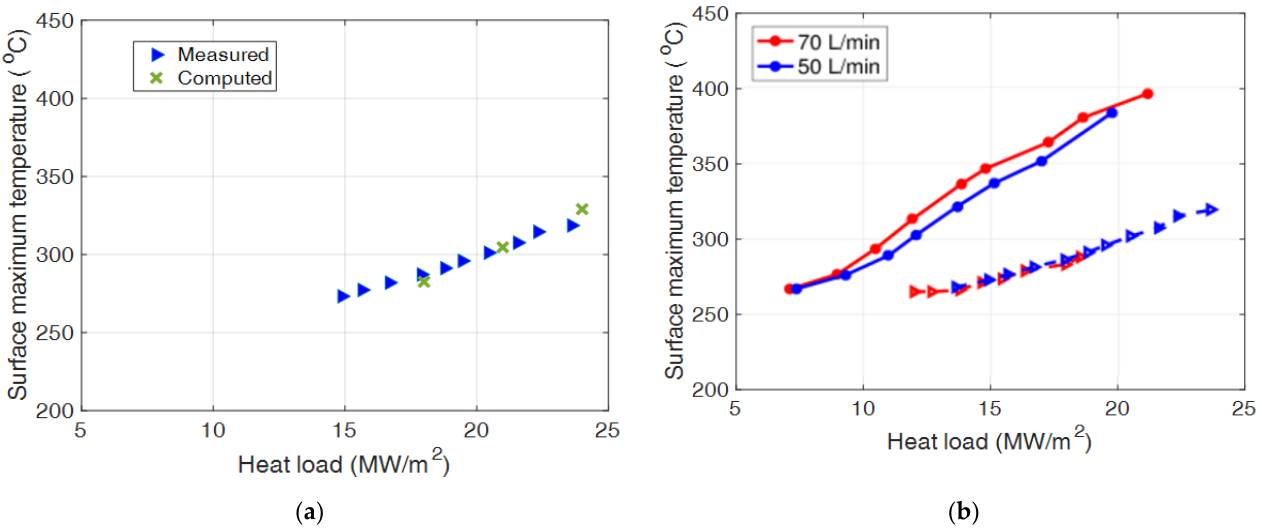
Figure 5. Cavity planar mock-ups equipped with RR: surface temperature measured as a function of the heating power. ( a ) 2015 test campaign with a water flow rate of 50 L/min: experimental data measured via the IR camera (blue symbols) and computed data with the calibrated model (green symbols). ( b ) Comparison between the data from the 2015 test campaign (triangles), measured with the IR camera, and the data from the 2016 test campaign (circles), measured with the pyrometer, with a water flow rate of 50 L/min (blue lines and symbols) and 70 L/min (red lines and symbols).